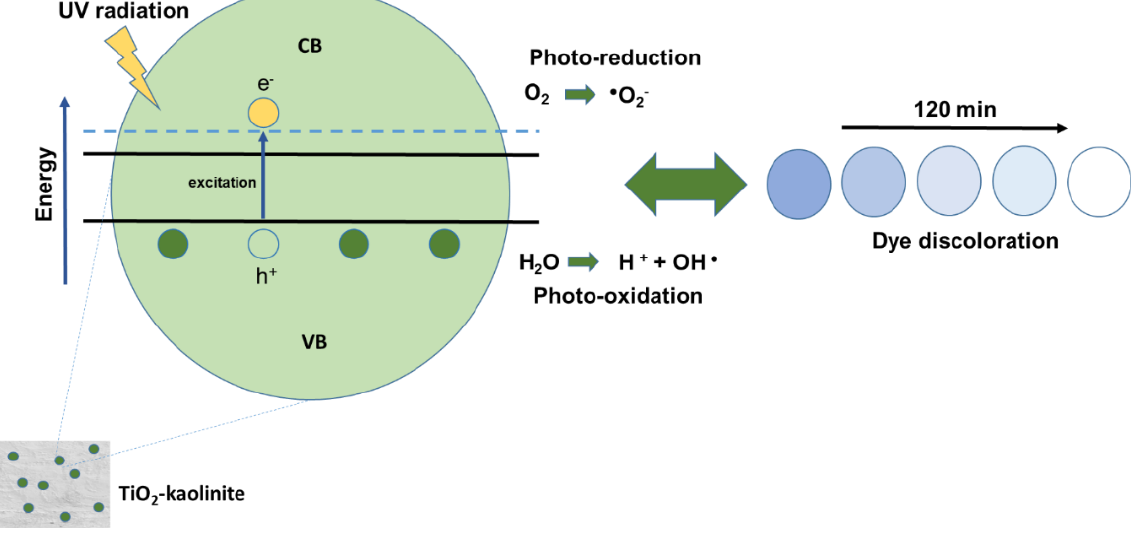
Figure 6. Photocatalysis mechanism proposal for discoloration of the blue dye solution from kaolinite-based nanocomposite under UV light.